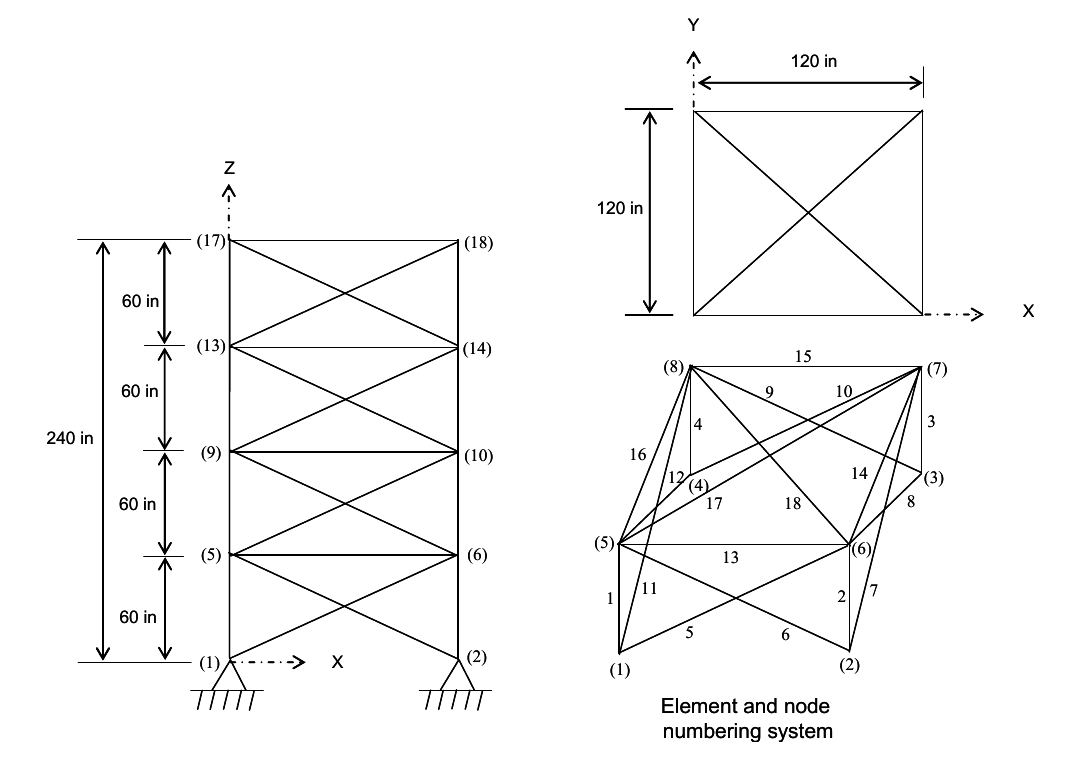
Figure 6. Schematic of the spatial 72-bar truss structure. Table 7. Loading conditions acting on the 72-bar truss.